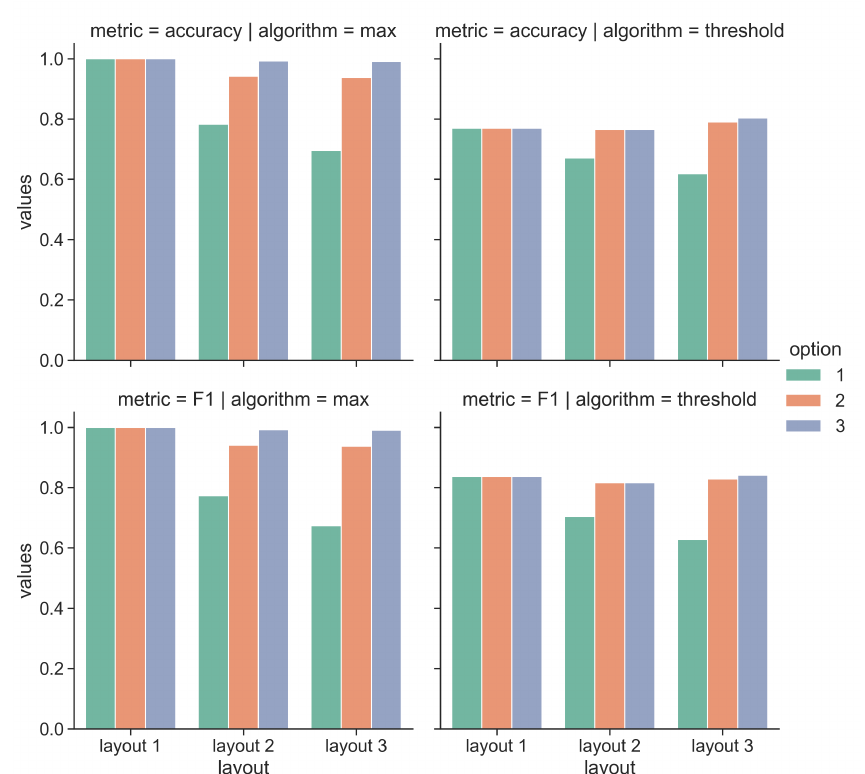
Figure 18. Performance results of the proximity algorithms with pilot